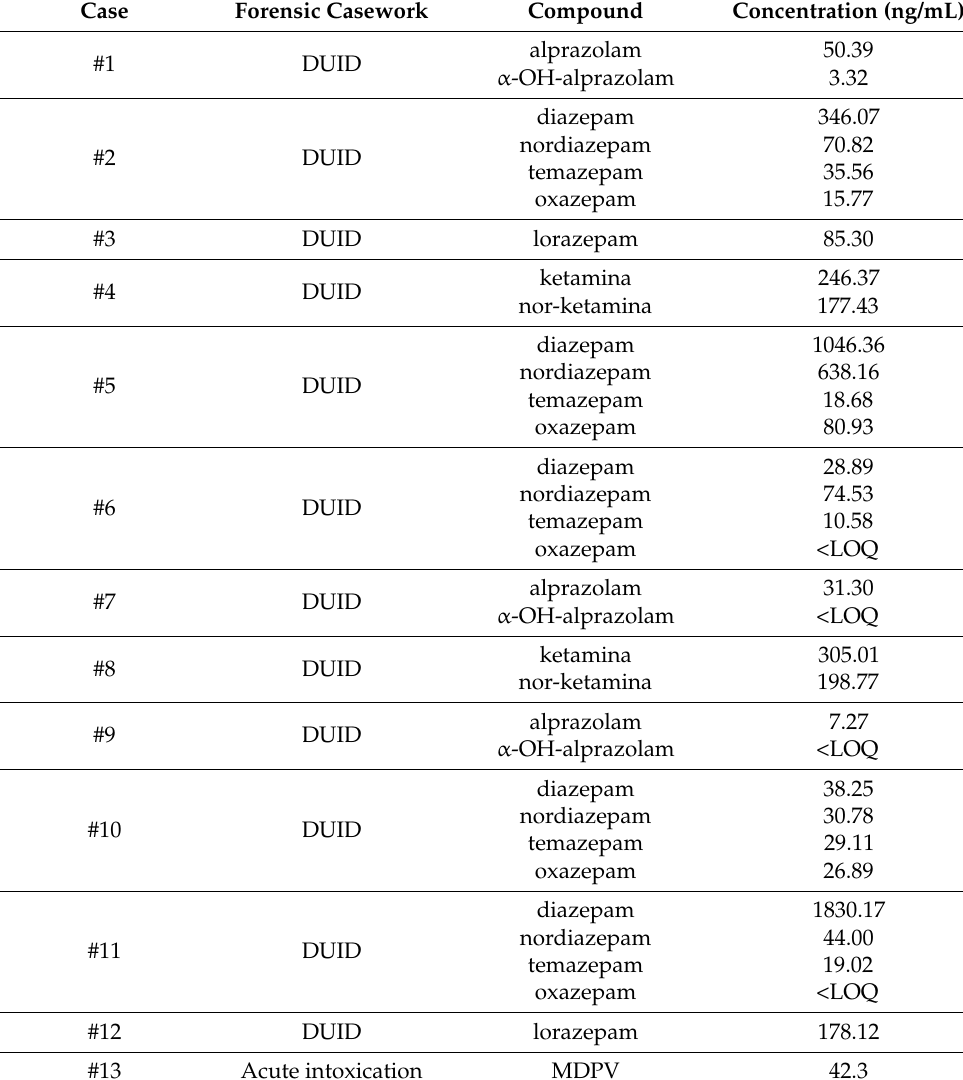
Table 3. Concentrations found in real cases of